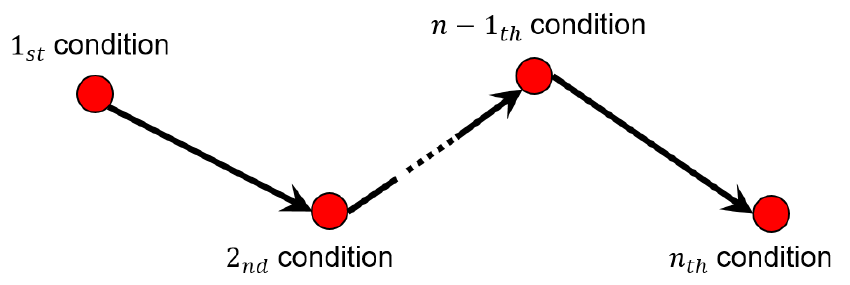
Figure 5. General scheme of the proposed search